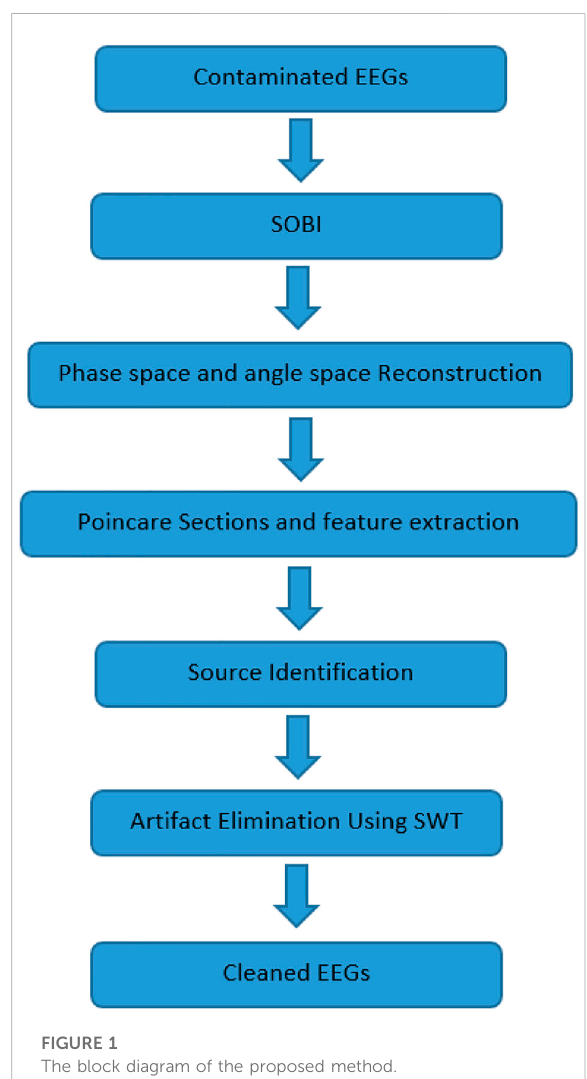
FIGURE 1 The block diagram of the proposed